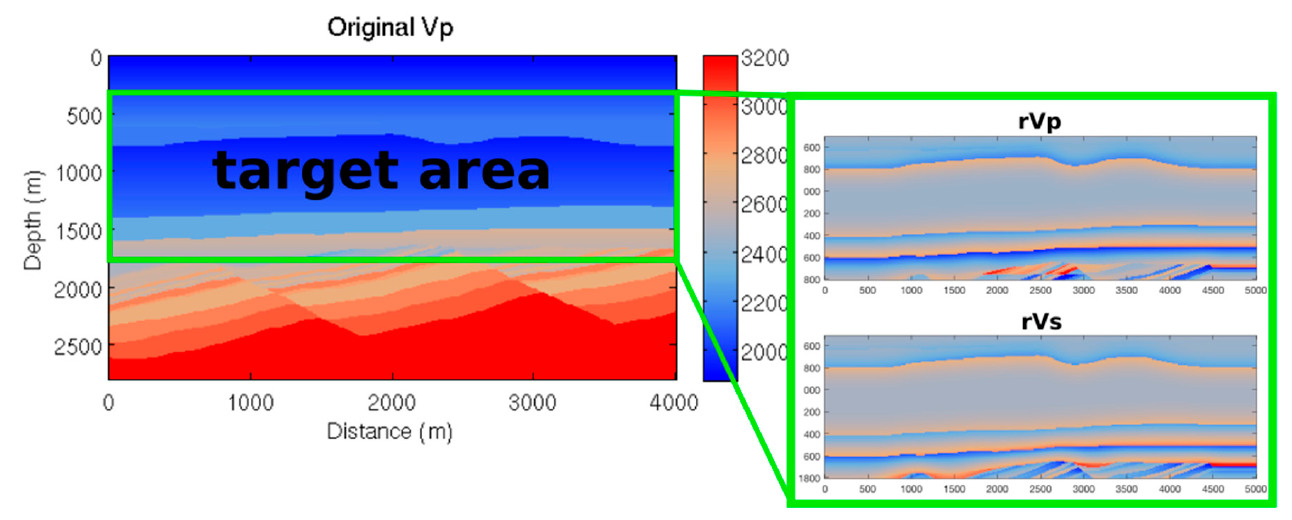
(cid:0) (cid:1) rV p , rV s on the